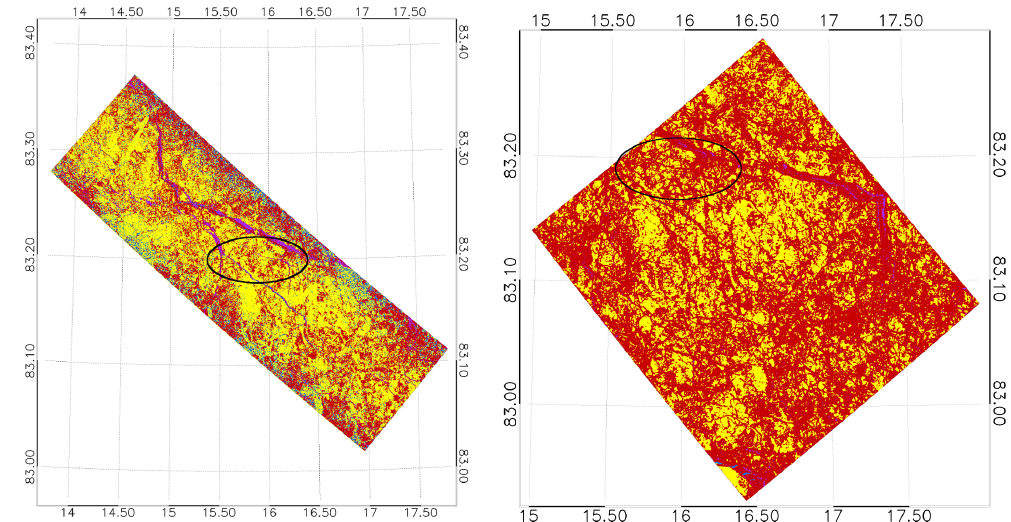
Figure 9. Comparison of classification results. For orientation, black ellipses indicate same ice structures. ( Left ) ice classification of TS-X acquisition on 23 April 2015; ( Right ) ice classification of RS-2 acquisition on 23 April 2015. Blue: open water/nilas (OW), purple: young ice (YI), yellow: first